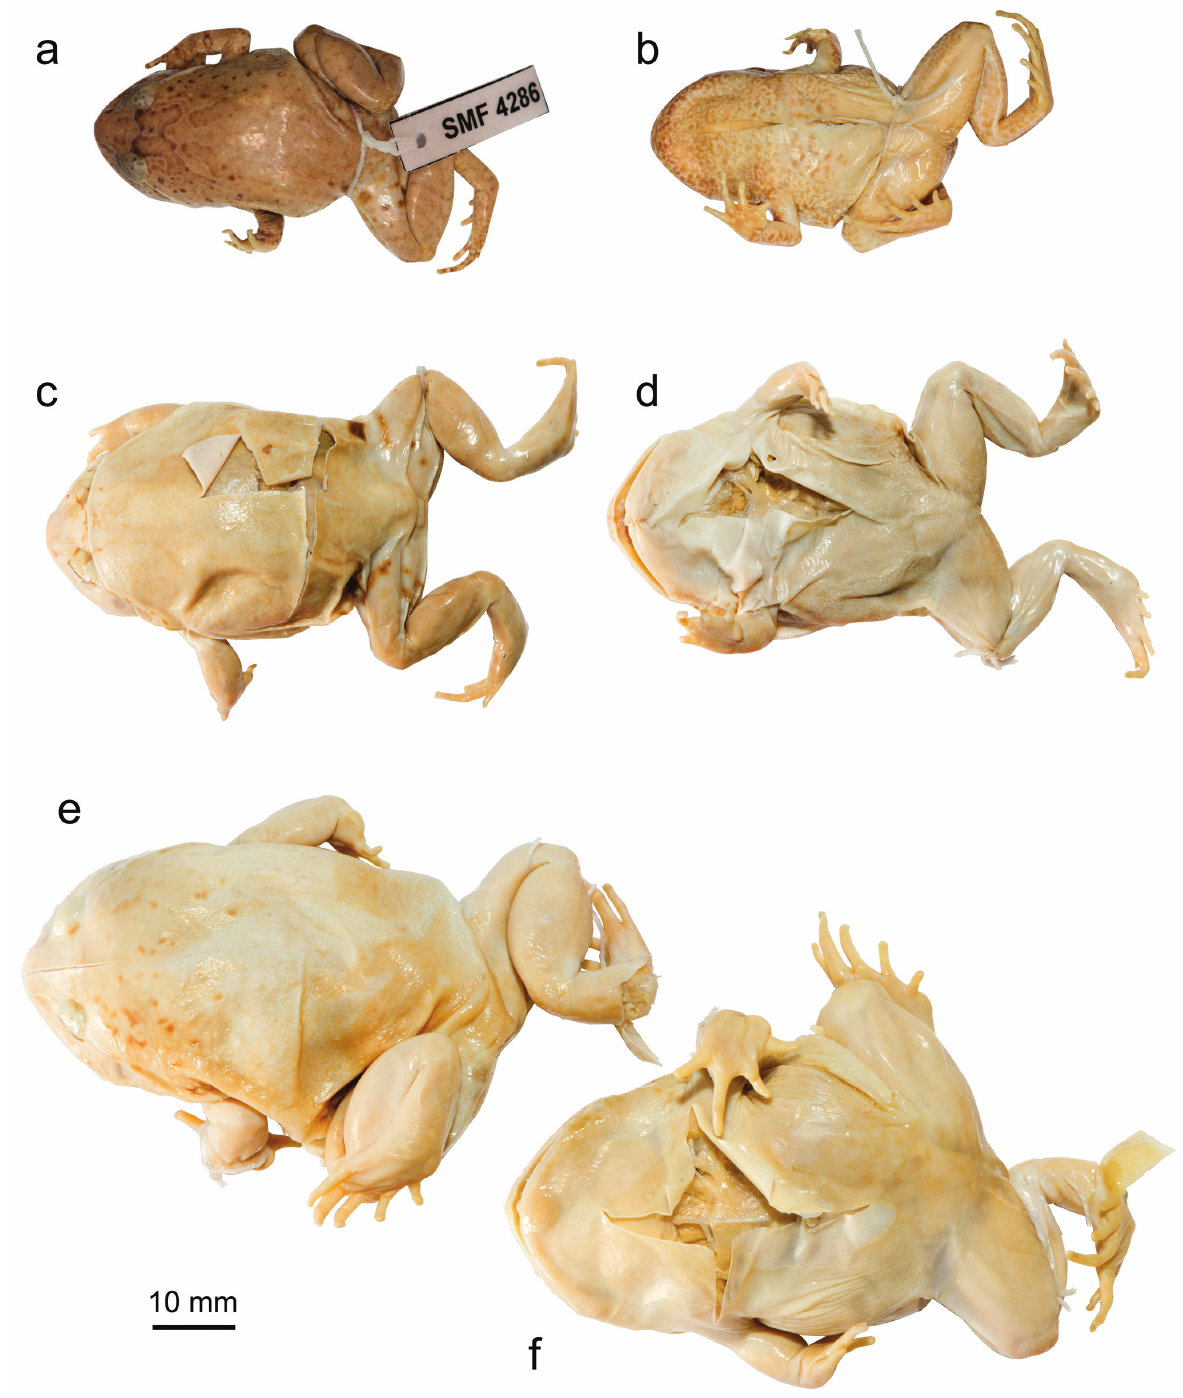
Figure 2. Photographs of the holotypes of ( a–b ) Phrynocara laeve (SMF 4286), ( c–d ) Dyscophus alluaudi (MNHN 1901.235) and ( e–f ) Plethodontohyla laevis tsianovohensis (MNHN 1936.47) in dorsal ( a, c, e ) and ventral ( b, d, f )